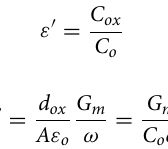
Figure 5 represents the C C–V and G c /ω–V plots for the Ag/TiO 2 -NW/Ge-NW/Si (MOS) device. It is observed after making the correction that is considering the effect of R s in C c versus V plot, there is no significant change plot confirms the charge transfer taking place at the interface 28 .